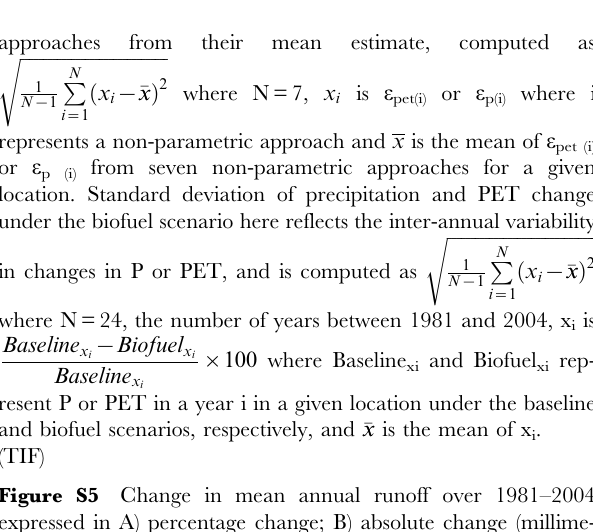
Figure S7 Streamflow prediction when mean annual P and PET are varied by (A) adding, and (B) subtracting a standard deviation of P holding PET constant at its mean annual value. (TIF) Table S1 Values of land use parameters in the NOAH land surface model as coupled within the WRF regional climate model. Text in bold face are the new land use categories and the associated parameterization of these categories used in the ffiffiffiffiffiffiffiffiffiffiffiffiffiffiffiffiffiffiffiffiffiffiffiffiffiffiffiffiffiffiffiffi switchgrass scenario. Meanings of the parameters are listed below 1 the table (from Anderson et al. [s19]). Table S2 Mathematical expression of f( ) and f’( ) across the